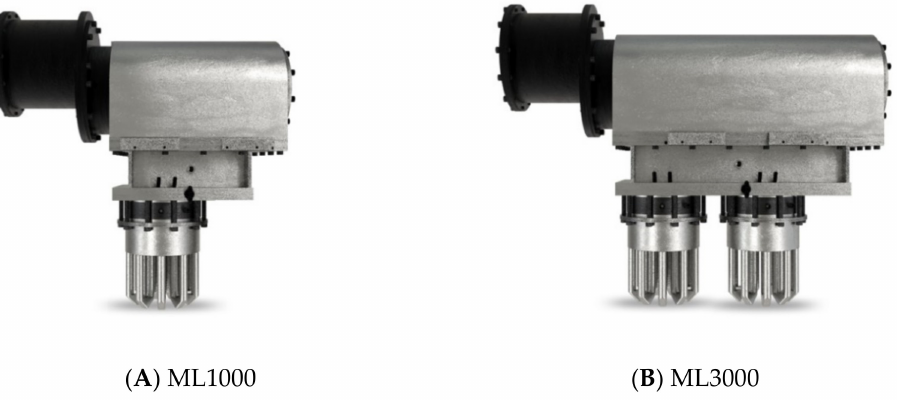
Figure 5. Genoastirling engines.